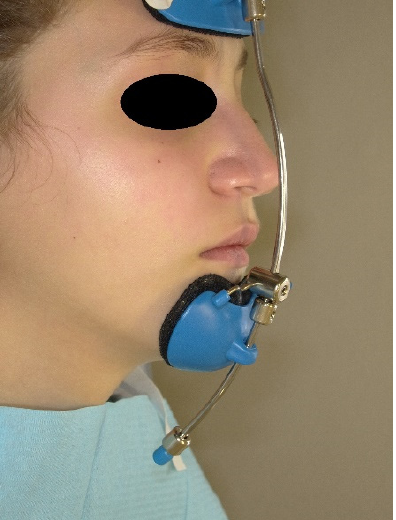
Figure 9. Oversized midline bar in a marketed standard facemask.